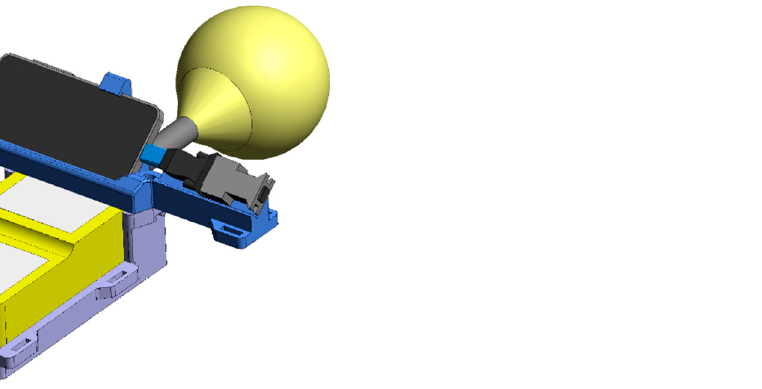
Figure 1. CAD drawing of the AR measurement system for magnetic fields. The yellow device with the spherical probe attached is the NARDA-EFA 300 measurement system, along with a standard size magnetic field probe. A custom designed 3D printed casing holds the EFA 300, with a SAMSUNG S20+ 5G smartphone running the AR application. The EFA 300 and the smartphone are connected via an optical cable and they communicate bidirectionally.